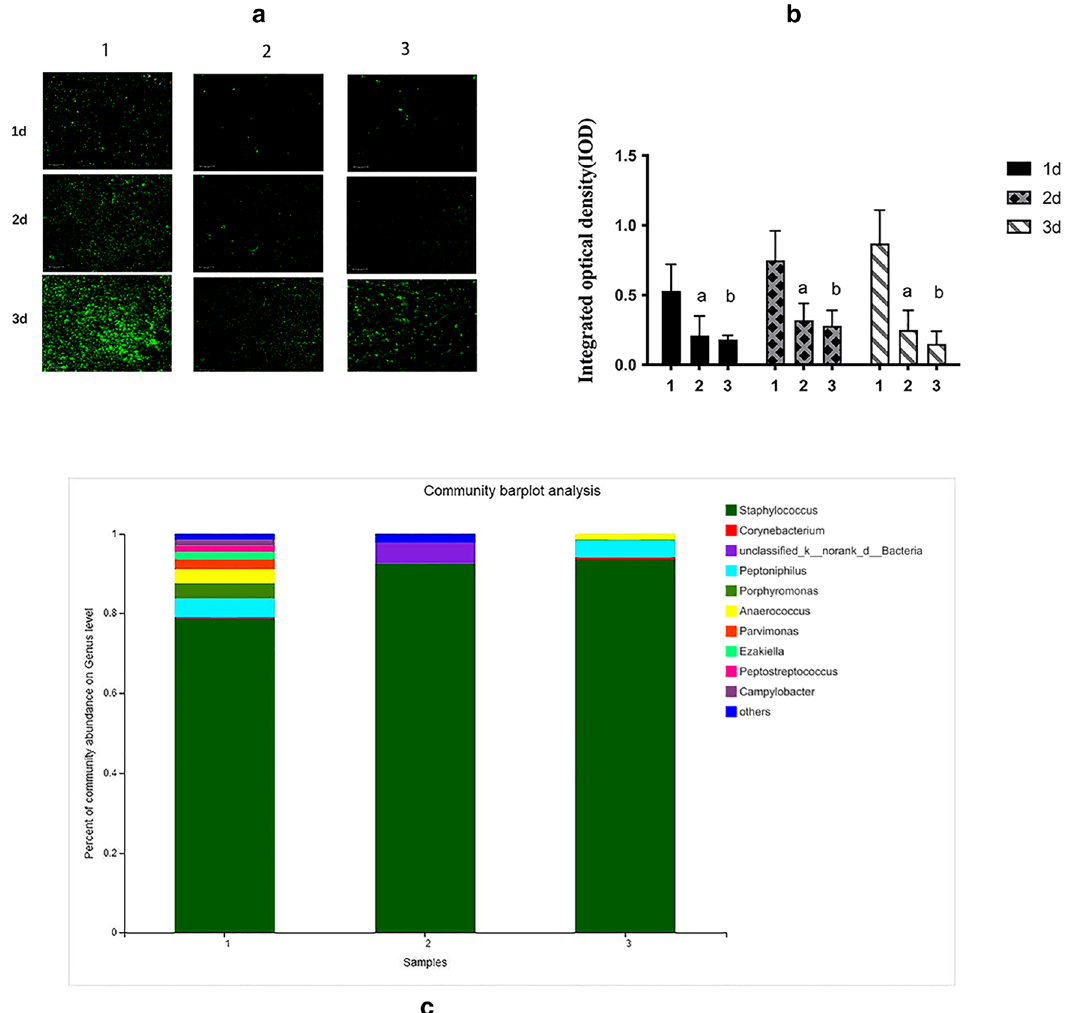
Figure 4. ( a ) The fluorescence images of biofilm after 1, 2, and 3 d (1: control groups; 2: OP-145; 3: vancomycin); ( b ) integrated optical density (IOD) of biofilm after 1, 2, and 3 d (1: control groups; 2: OP-145; 3: vancomycin); ( c ) the percentage of community abundance at the gene level after 3 d (1: control groups; 2: OP-145; 3: